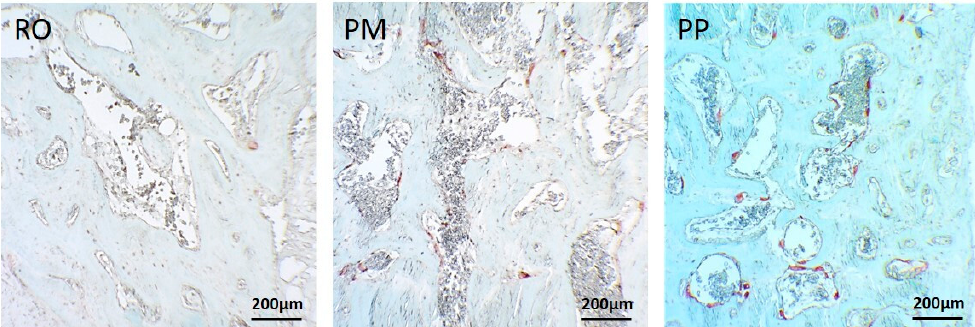
Figure 6. LM micrographs showing tartrate-resistant acid phosphatase (TRAP) reaction in the three osteotomies; in PM and PP osteotomies, the positivity (red color) is higher compared with RO.